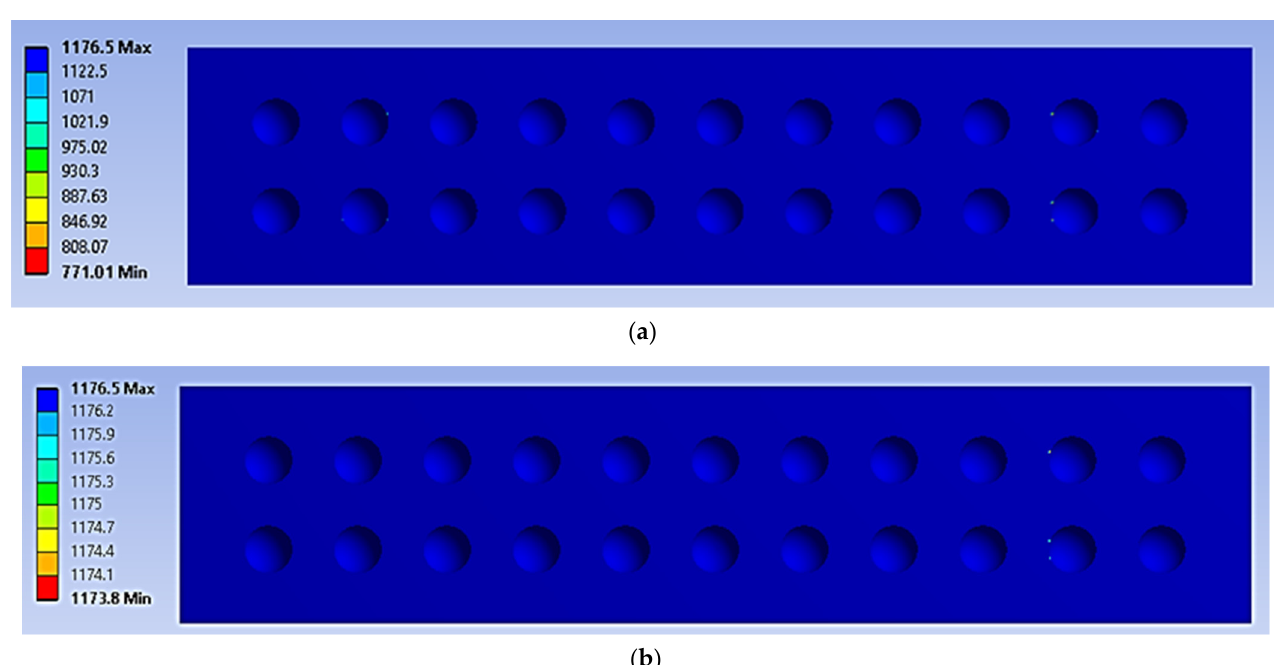
conditions (units in mm): ( a ) 70%, ( b ) 50%.